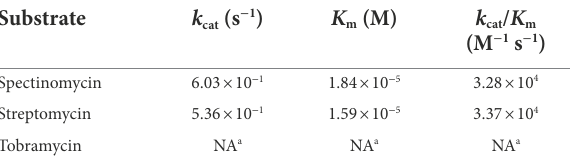
TABLE 6 Kinetic parameters of